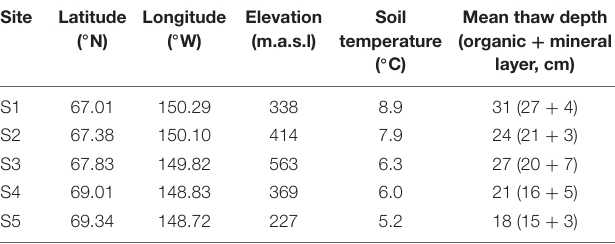
TABLE 1 | Sampling site